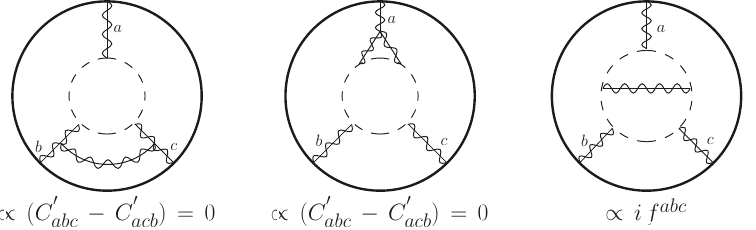
W ( C ) at g 6 order in the di(cid:11)erence theory is (cid:10) (cid:11)